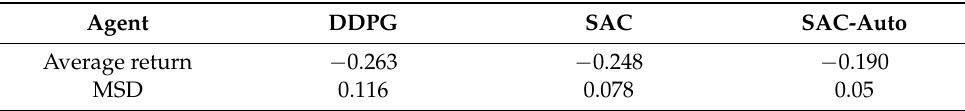
Table 4. Comparison of results after training.